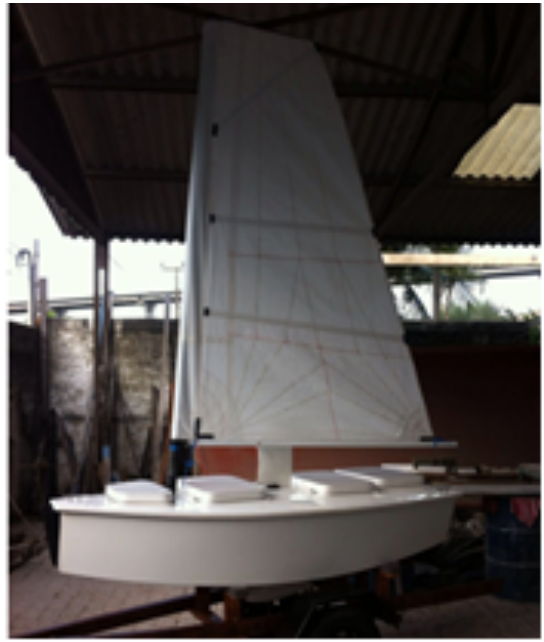
Figure 2. N-Boat—The Sailboat Robot construction is currently